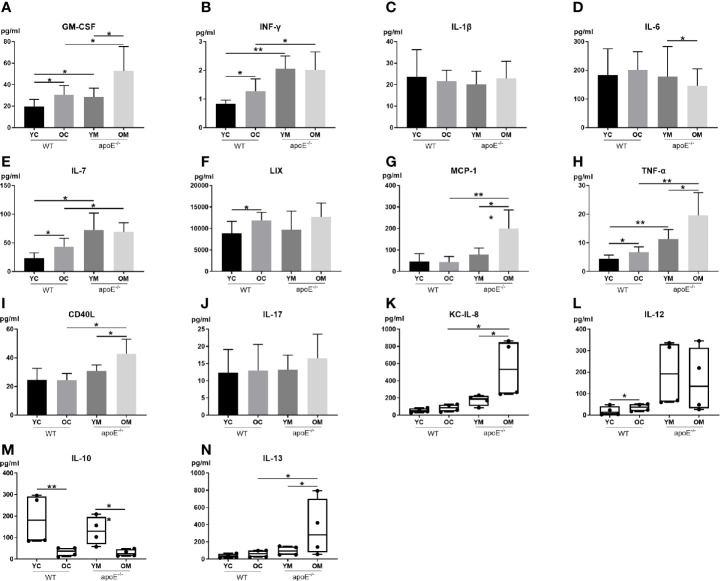
Quantification of serum inflammatory cytokines: (A–J) Data shown as mean ± SD; (K-N) Data were shown in boxplot format (horizontal bar represents the median, boxes encompass the 25th to 75th percentile and error bars encompass the 10th to 90th percentile). Data were shown as mean ± SD. *
p <0.05; **
p <0.01. p values are calculated from T-test and Wilcoxon rank sum test, n=6.